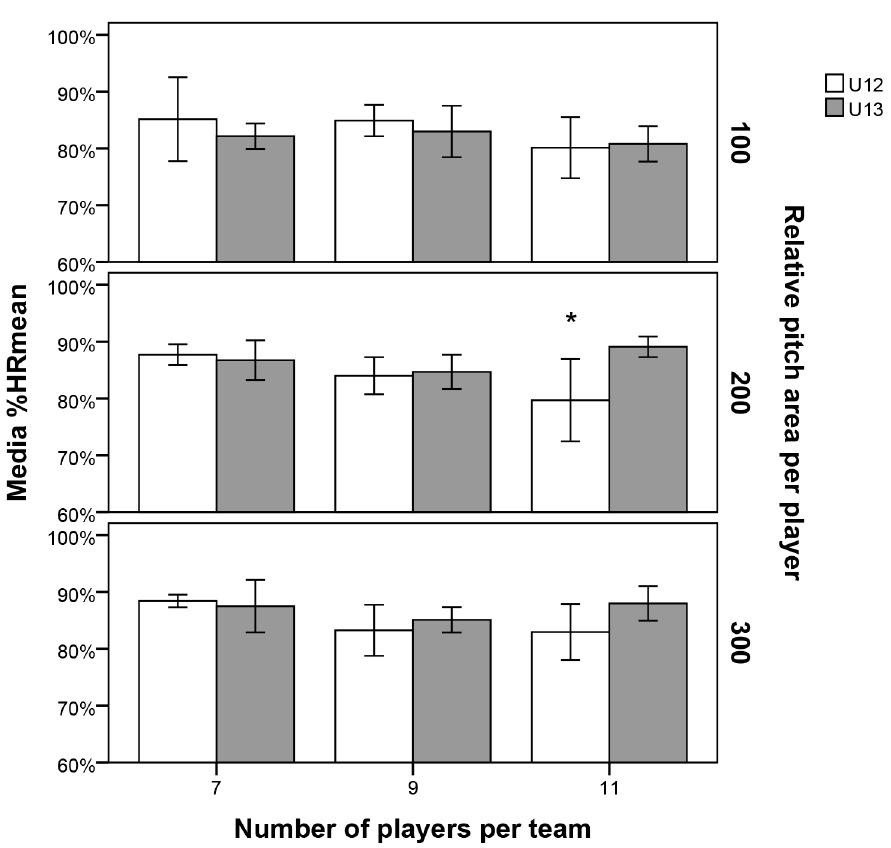
Fig 1. Mean and standard deviation ( ± SD) for the mean heart rate with respect to the individual maximum (%HR mean ) for each of the nine competitive formats. Note: 100, 200, and 300 represent, respectively, the relative pitch areas of 100 m 2 , 200 m 2 , and 300 m 2 per player, while 7, 9, and 11 correspond to the number of players per team (7, 9, and 11, respectively). * Significant difference between categories p <